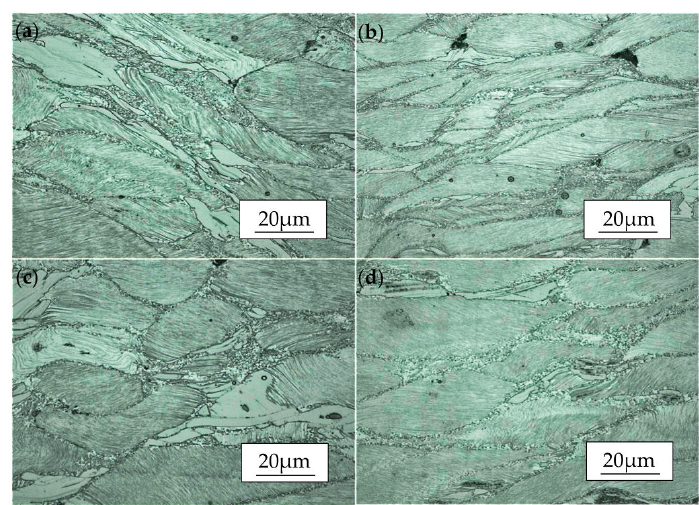
Figure 7. Microstructure of the Mg-13.5Gd-3.2Y-2.3Zn-0.5Zr alloy compressed at the temperature of 450 ◦ C and strain rate of ( a ) 1/s, ( b ) 0.1/s, ( c ) 0.01/s, and ( d )